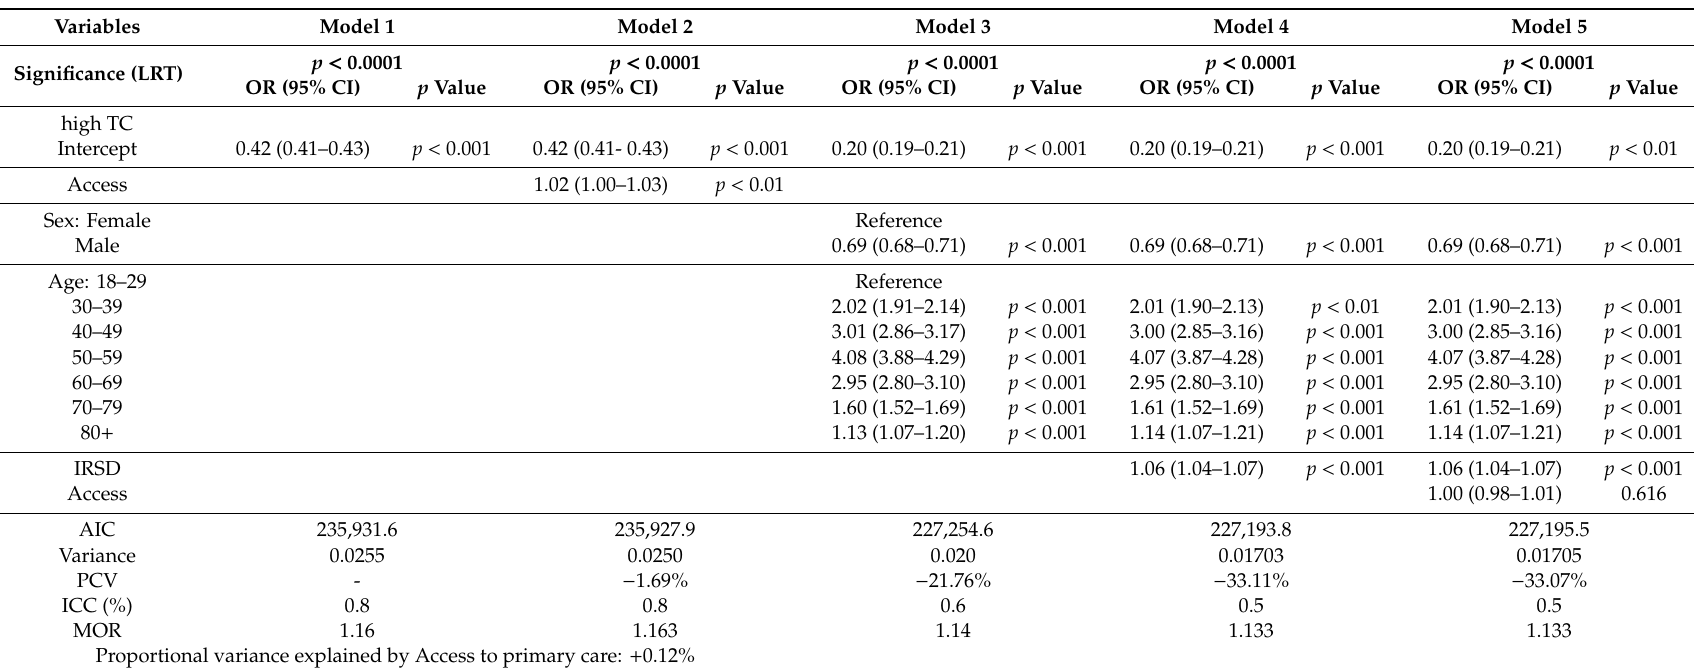
Table 5. Multilevel logistic regression model summaries of high TC (TC ≥ 5.5 mmol /